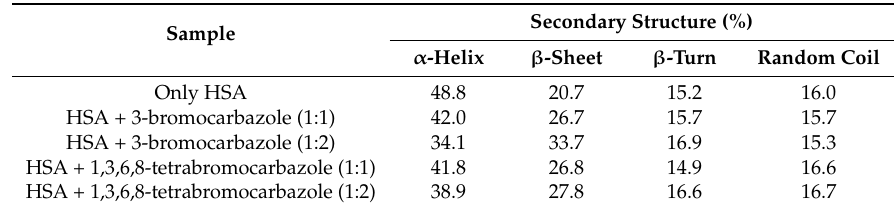
Table 4. Conformation changes in the secondary structure of HSA with and without 3-bromocarbazole and